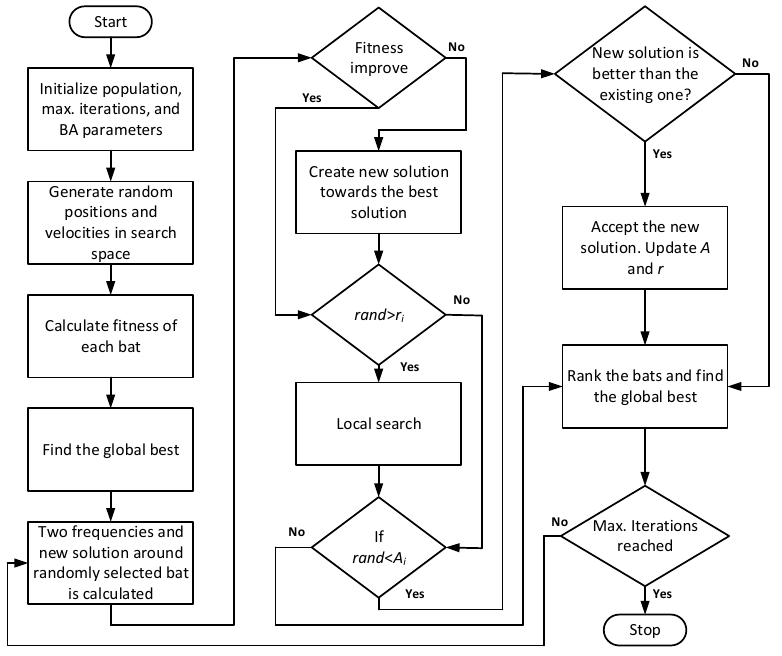
Figure 3. Flow chart of the directional bat algorithm (dBA).